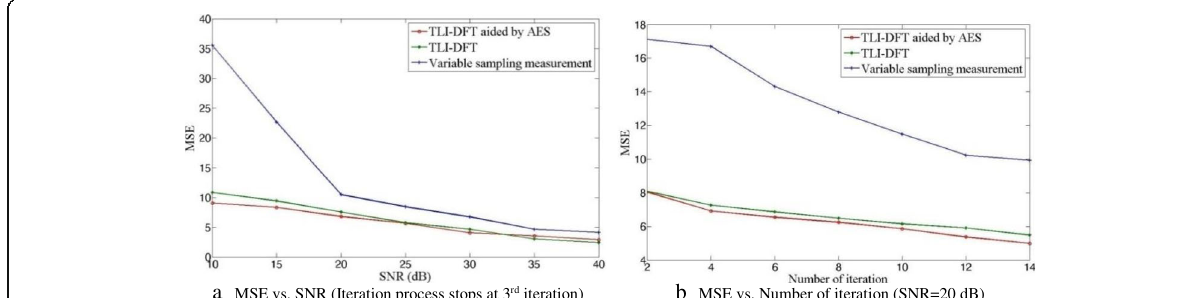
Fig. 16 Performance of three algorithms with decaying DC offsets (considering the time constants of two decaying DC offsets. T DC = 10 cycle)